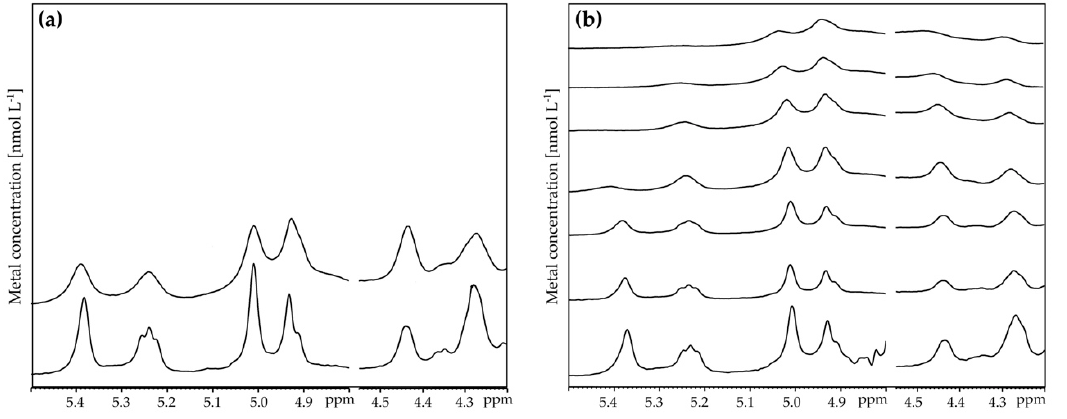
Figure 4. H NMR spectra of EPS-SC3I(2) in D 2 O in presence of increased amounts of Ni 2+ ( a ) and Cu 2+ ( b ), pH 5.1, T = 25 ◦ C.